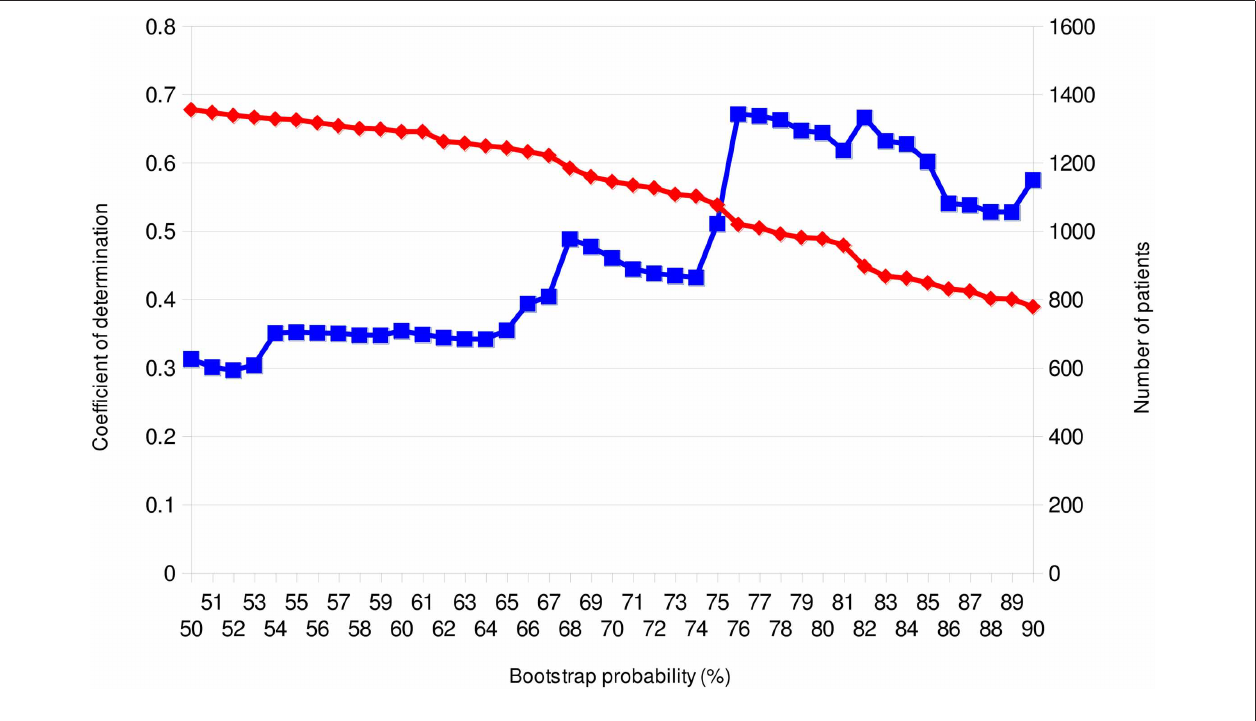
FIGURE 5 | Bootstrap-scanning on power-law fitting of clusters in the Neighbor-Joining tree. The adjusted coefficients of linear regression determination of log-log plots and the number of individuals in the clusters are plotted on the bootstrap cut-off probability for the clade distinction. The blue line with square symbols and the red line with lozenge symbols show the coefficients of determination and the numbers of individuals included